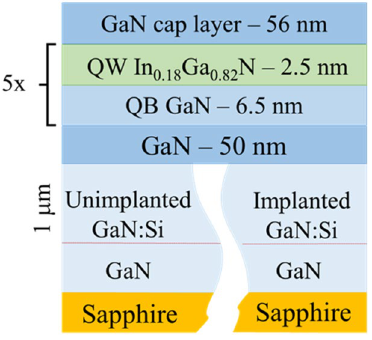
Figure 2. The scheme of InGaN/GaN MQWs grown on layers described in paragraph GaN:Si layers: unimplanted and implanted.